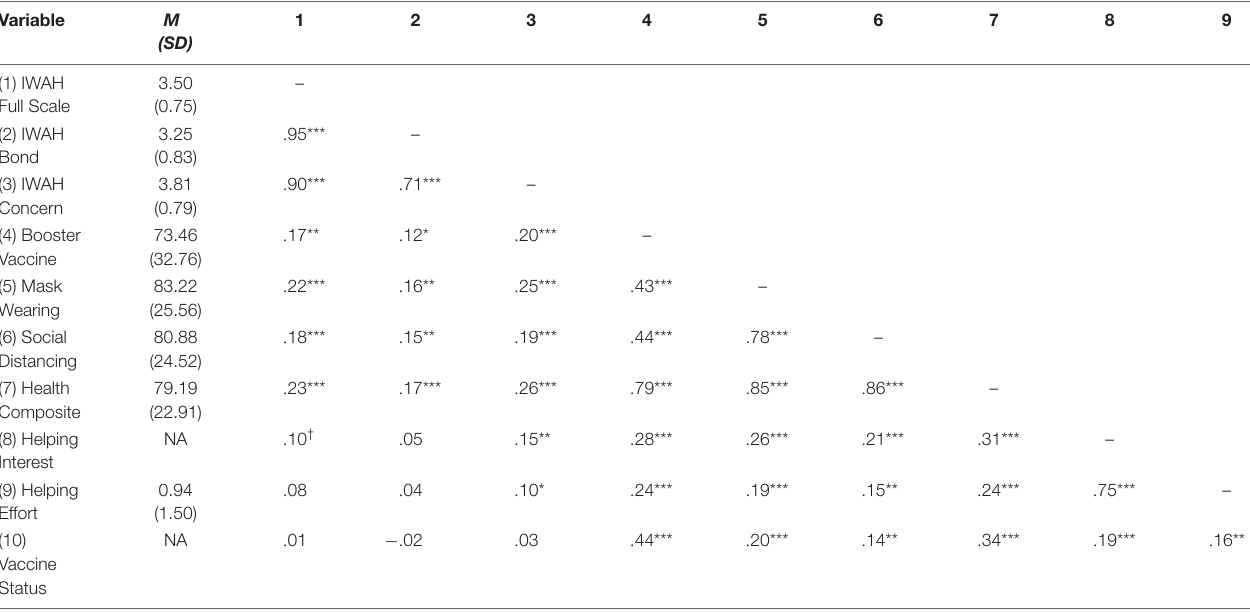
TABLE 3 | Descriptive statistics and bivariate correlations of all primary measured variables in Study 2.